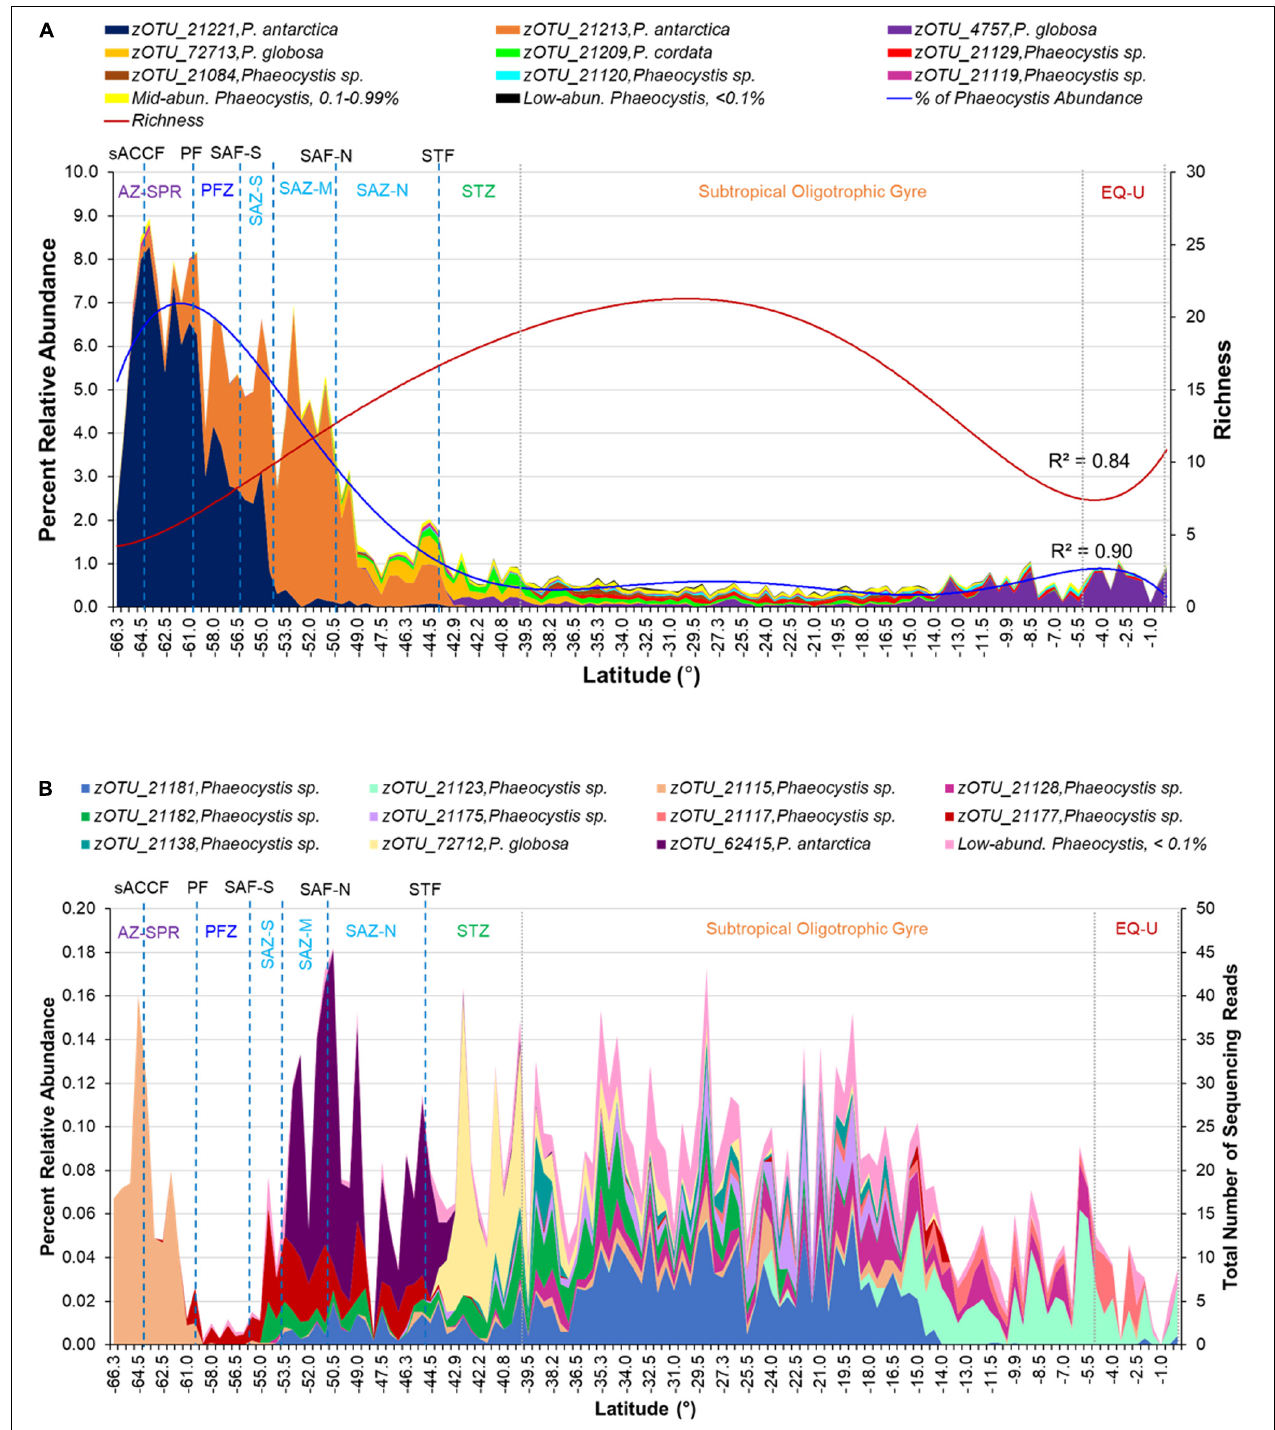
FIGURE 4 | (A) Percent relative abundance of high-abundance Phaeocystis zOTUs (relative abundance > 1% of all Phaeocystis 18S rRNA gene sequences) above the Ab-Ub threshold within the P15S transect. Mid- (0.1–0.99% of all Phaeocystis 18S rRNA gene sequences) and low- ( < 0.1% of all Phaeocystis 18S rRNA gene sequences) abundance zOTUs are indicated as separate, pooled categories. Richness (red line) and percent relative abundance (blue line) profiles of the Phaeocystis assemblage fitted with a sixth-order polynomial regression curve are overlaid. (B) Average relative abundance of mid-abundance Phaeocystis zOTUs above the Ab-Ub threshold. Low-abundance zOTUs are indicated as a pooled category. Approximate locations of fronts are indicated by blue dotted lines, while approximate boundaries for subtropical gyre and equatorial upwelling zones are indicated by gray dotted lines. Acronyms for fronts and zones are as listed in Figure 1 .